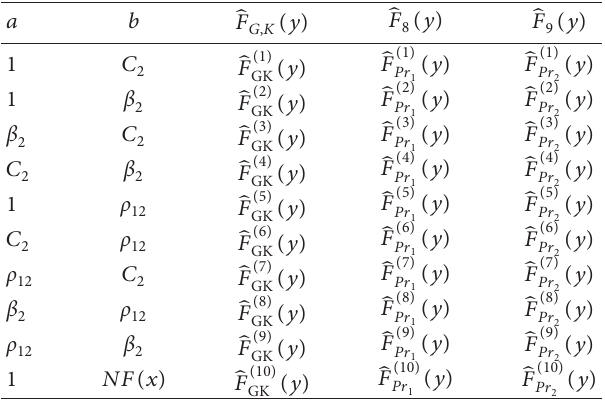
Table 2: Some members of the adapted and proposed distribution function